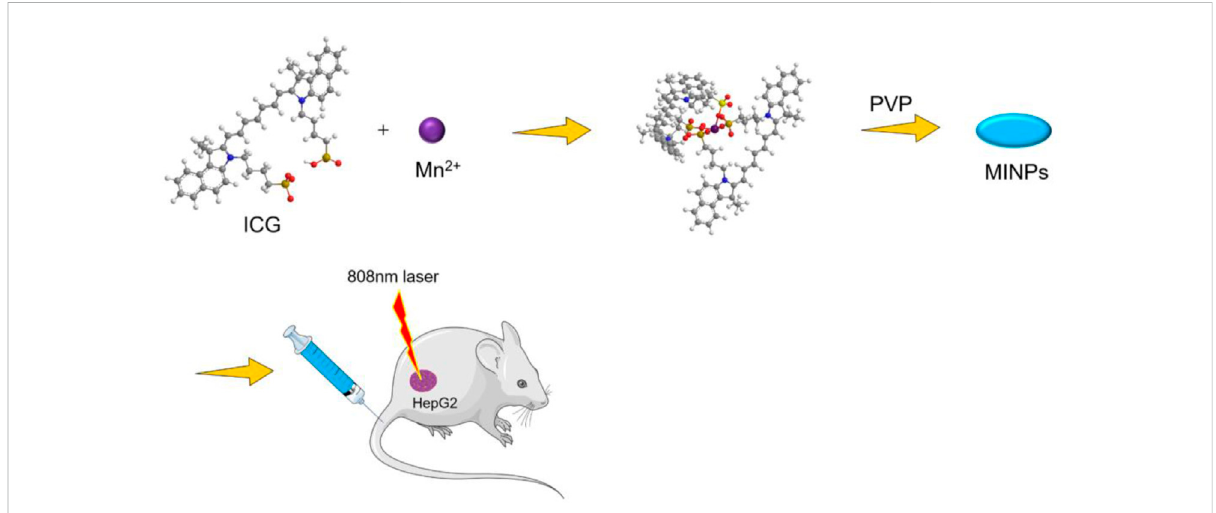
FIGURE 1 Synthesis and application of MINP. The schematic pieces were provided by Smart Medical Art and adapted [http://www.servier.com]. Servier Medical Art by Servier is licensed under a Creative Commons Attribution 3.0 Unported License.